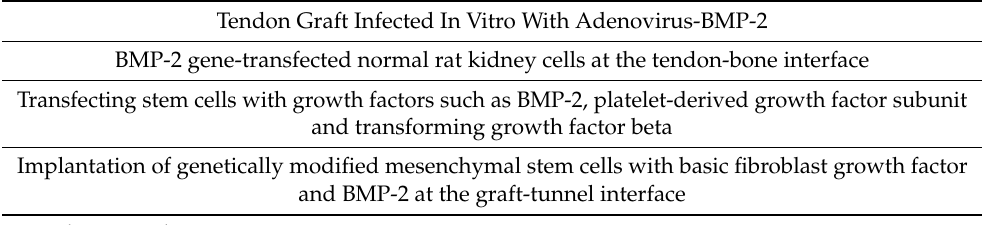
Table 7. Gene therapies employed in anterior cruciate ligament reconstruction. Tendon Graft Infected In Vitro With Adenovirus-BMP-2 BMP-2 gene-transfected normal rat kidney cells at the tendon-bone interface